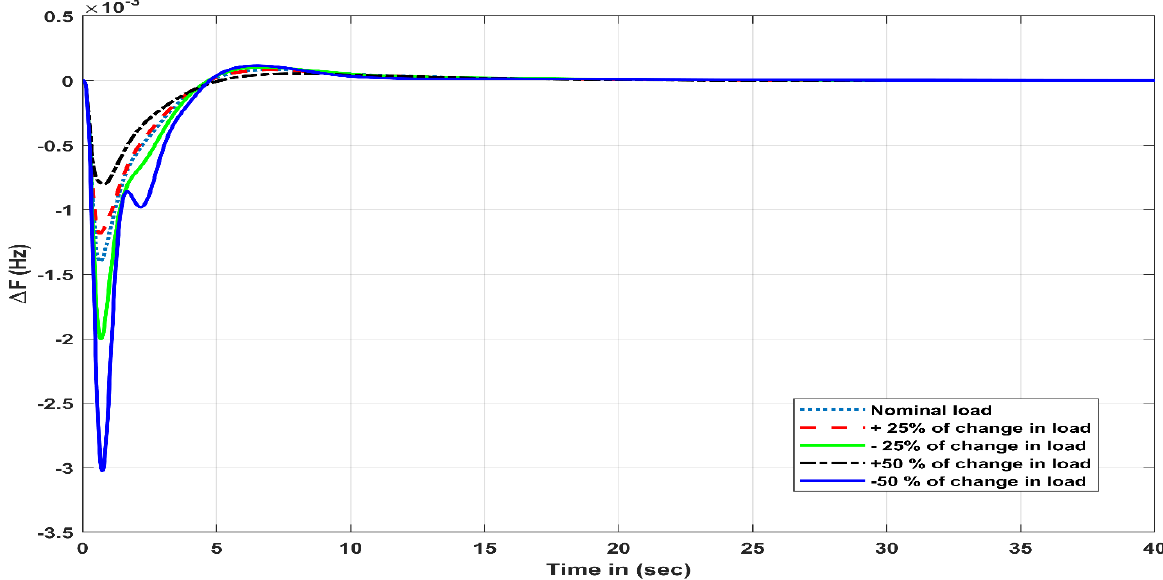
Figure 9. Load variation for the marine microgrid system from ±25% to ±50%.